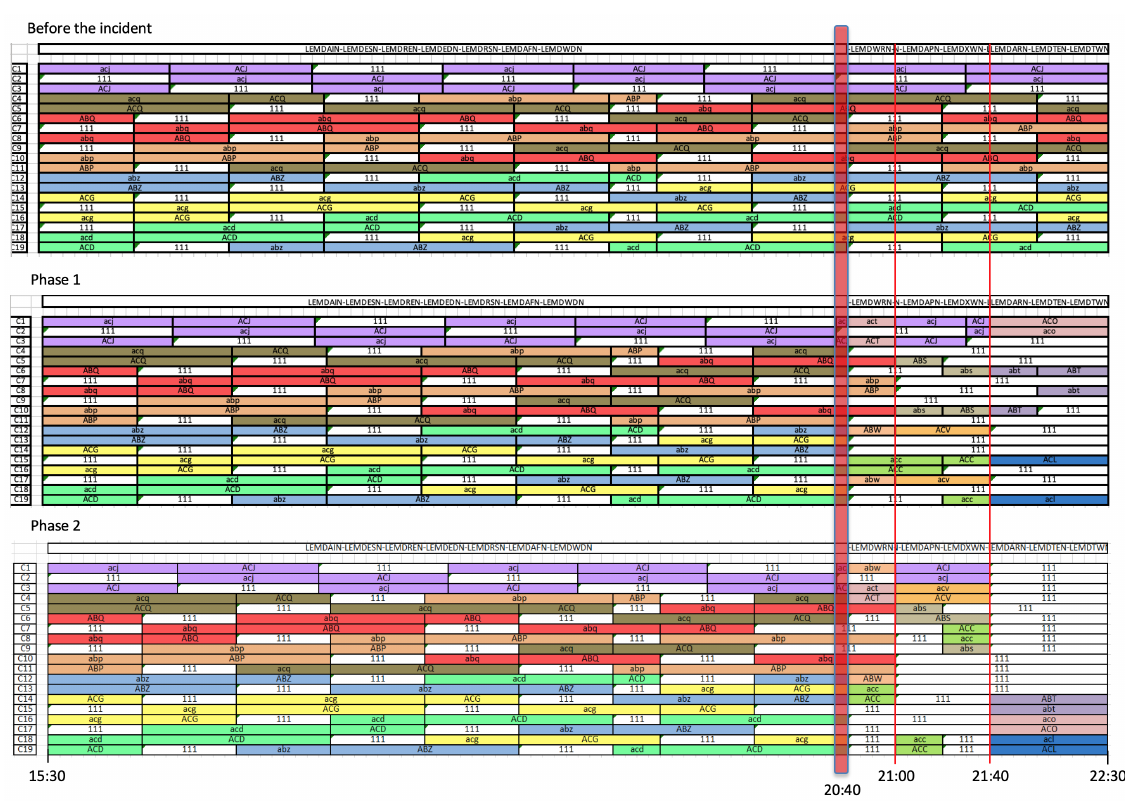
Figure 14. Solution before the incident, solution derived in Phase 1 and solution for Instance